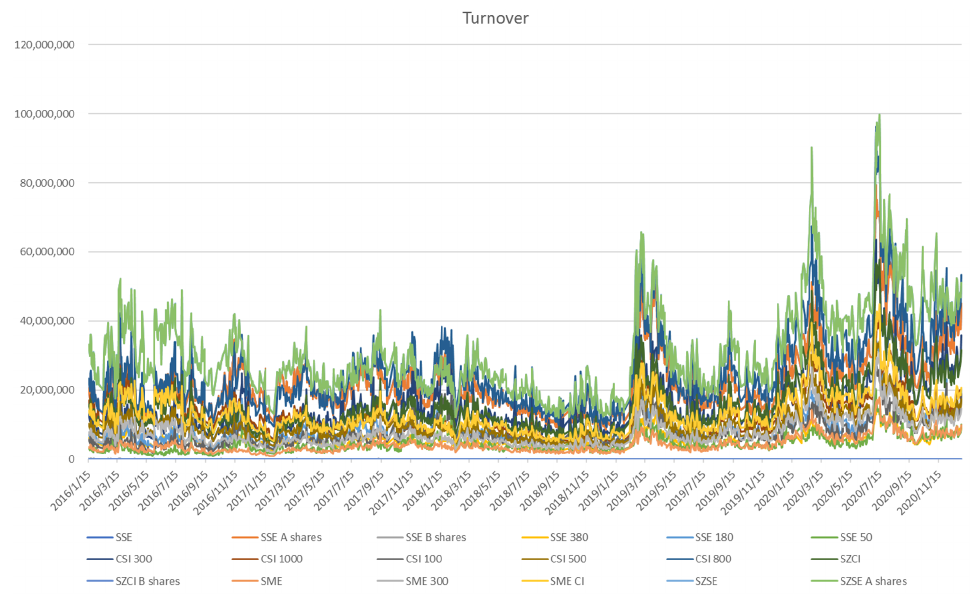
Figure A6. History of turnover in 18 Chinese stock